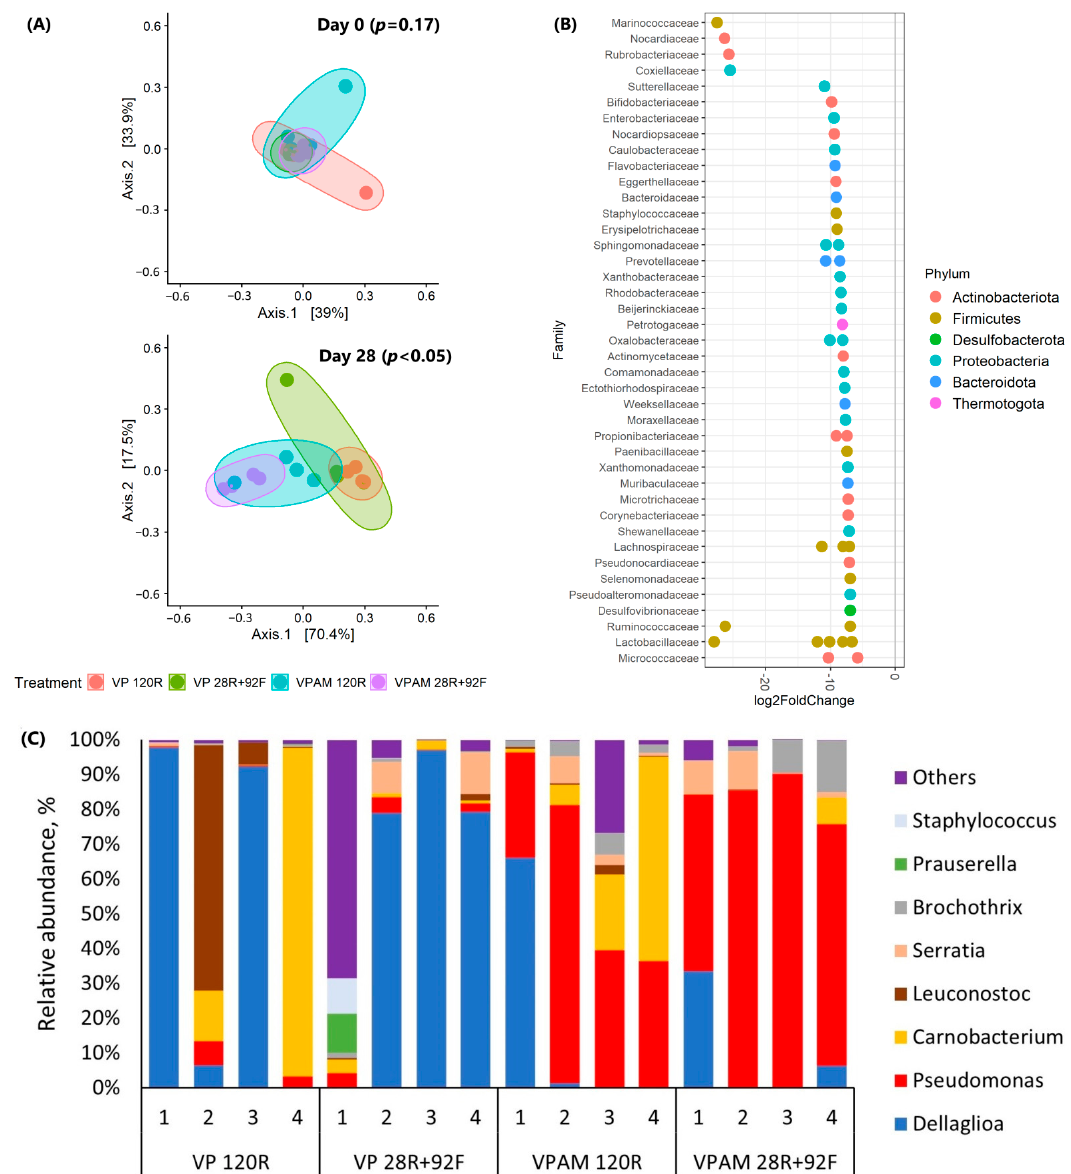
Figure 4. ( A ) The principal coordinate plot of beta diversity measured by weighted UniFrac distances at amplicon sequence variants (ASV) level on days 0 (top) and 28 (bottom). ( B ) Significant ( p < 0.05) differential genera in meat vacuumed packaged with or without antimicrobial. Genera are grouped by family (y-axis) and color-coded according to the phyla they belong to. Negative log 2 fold values mean enrichments in samples without antimicrobial. ( C ) Relative abundance (%) of most predominant bacterial genera in individual meat samples for each treatment on day 28 of storage. Treatments: vacuum packaging for 120 days (refrigerated) (VP 120R), vacuum packaging for 28 days (refrigerated) + 92 days (frozen) (VP 28R+92F), vacuum packaging with antimicrobial for 120 days (refrigerated) (VPAM 120R), vacuum packaging with antimicrobial for 28 days (refrigerated) + 92 days (frozen) (VPAM 28R+92F).